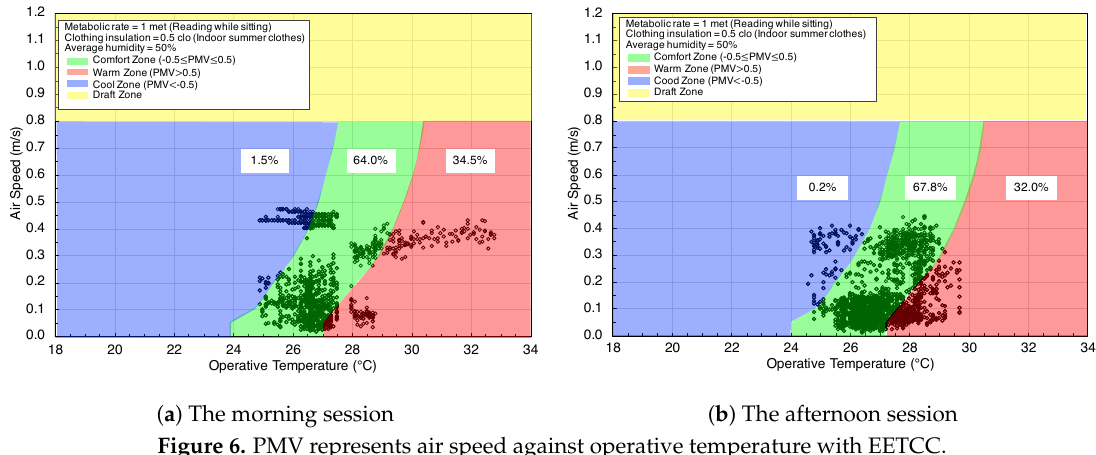
Figure 6. PMV represents air speed against operative temperature with